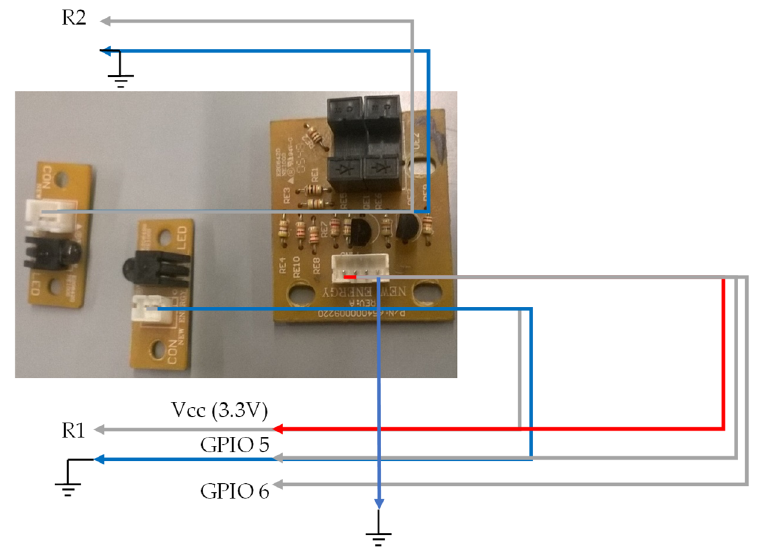
Figure 27. Document thickness measuring plate, with reference to the electrical connections.